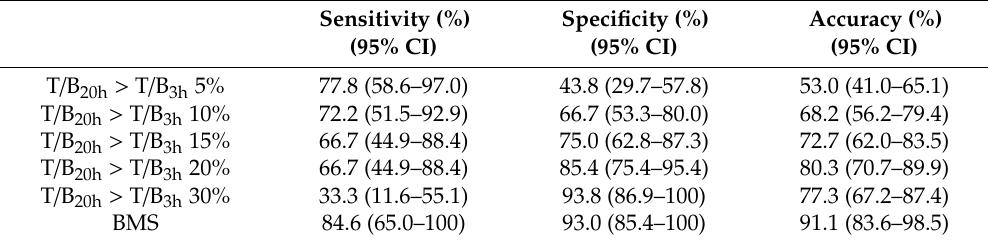
Table 4. Overview of the performance of different diagnostic approaches in doubtful qualitative analysis. Table4. Overviewoftheperformanceofdi ff erentdiagnosticapproachesindoubtfulqualitativeanalysis. Sensitivity (%)